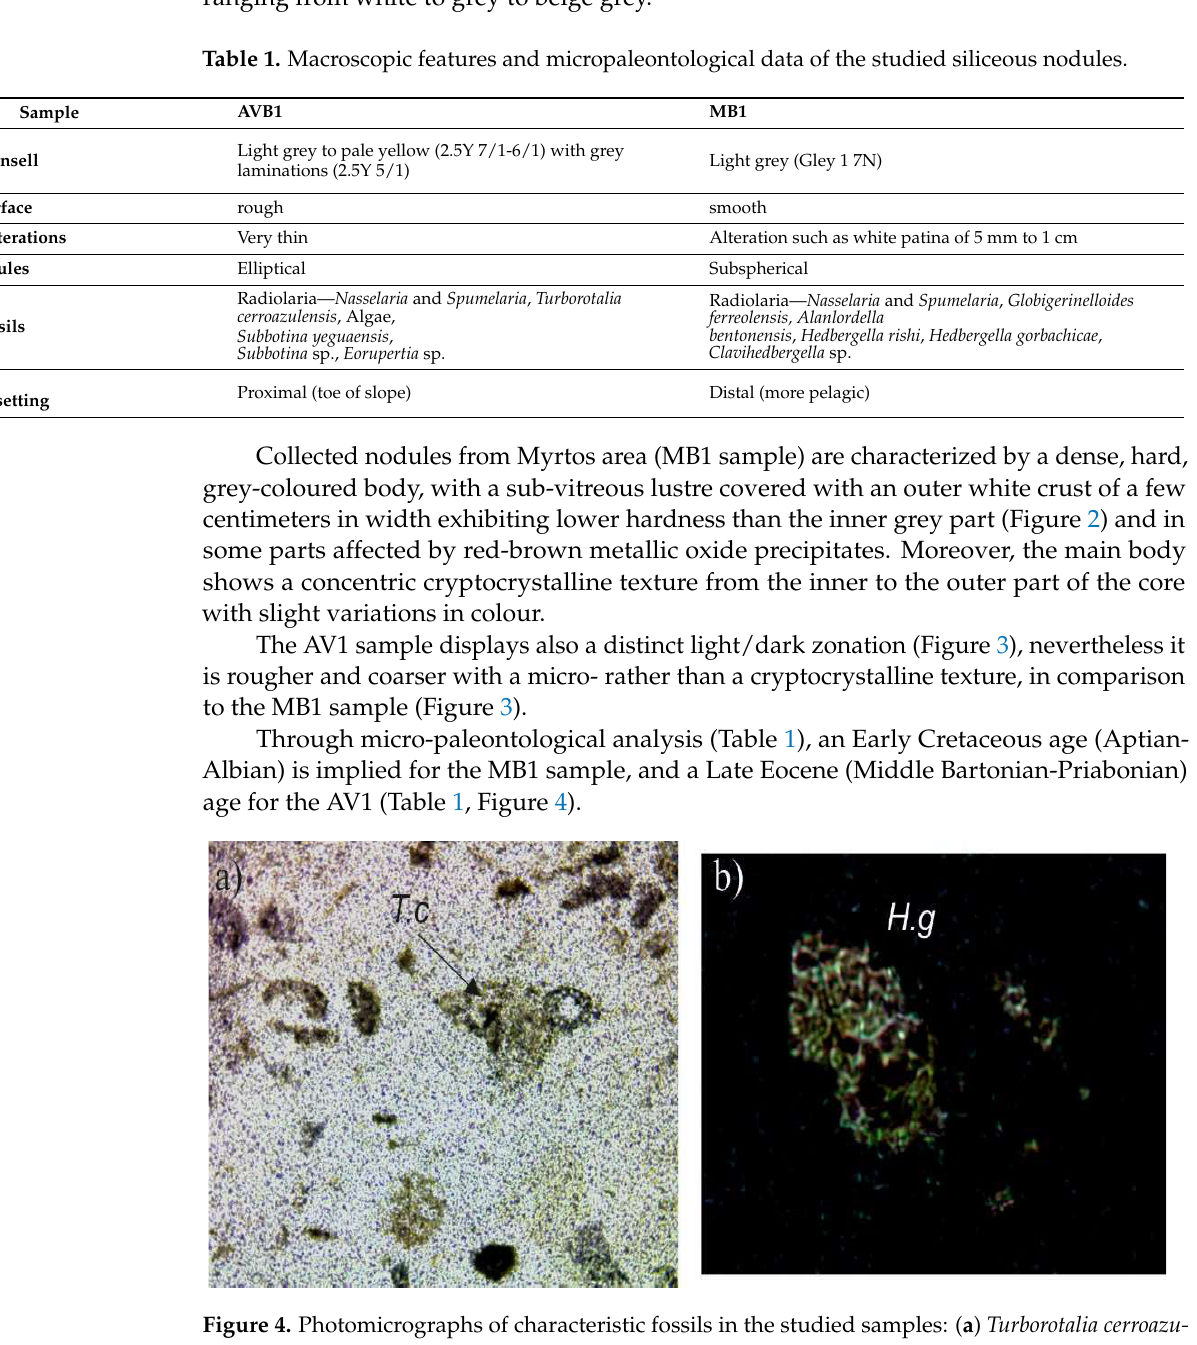
Table 1. Macroscopic features and micropaleontological data of the studied siliceous nodules.